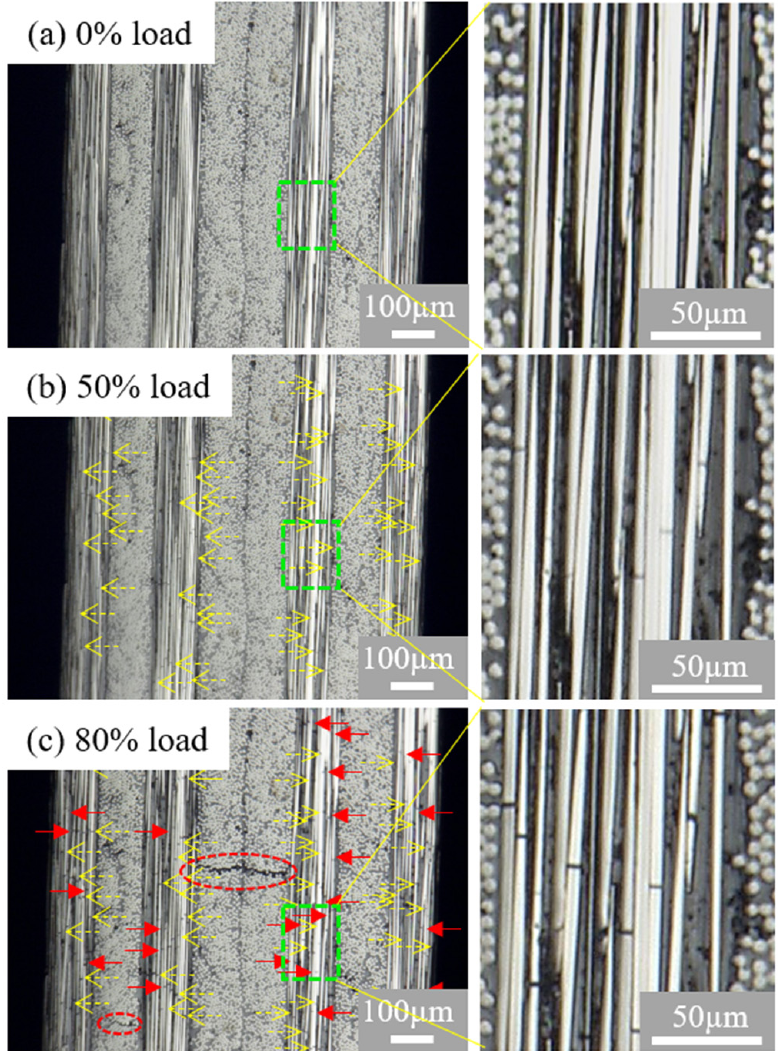
Figure 6. Failure images at the free edge of the [0/75] 2s laminates. ( a ) Before the test, ( b ) at 50% load, ( c ) at 80% load. The dashed open arrows (yellow) refer to the fiber breakages observed at 50% load; the solid arrows (red) refer to new fiber breakages observed at 80%. The red dash circle refers to matrix crack observed at 80% load. The enlarged images are the green dashed regions.